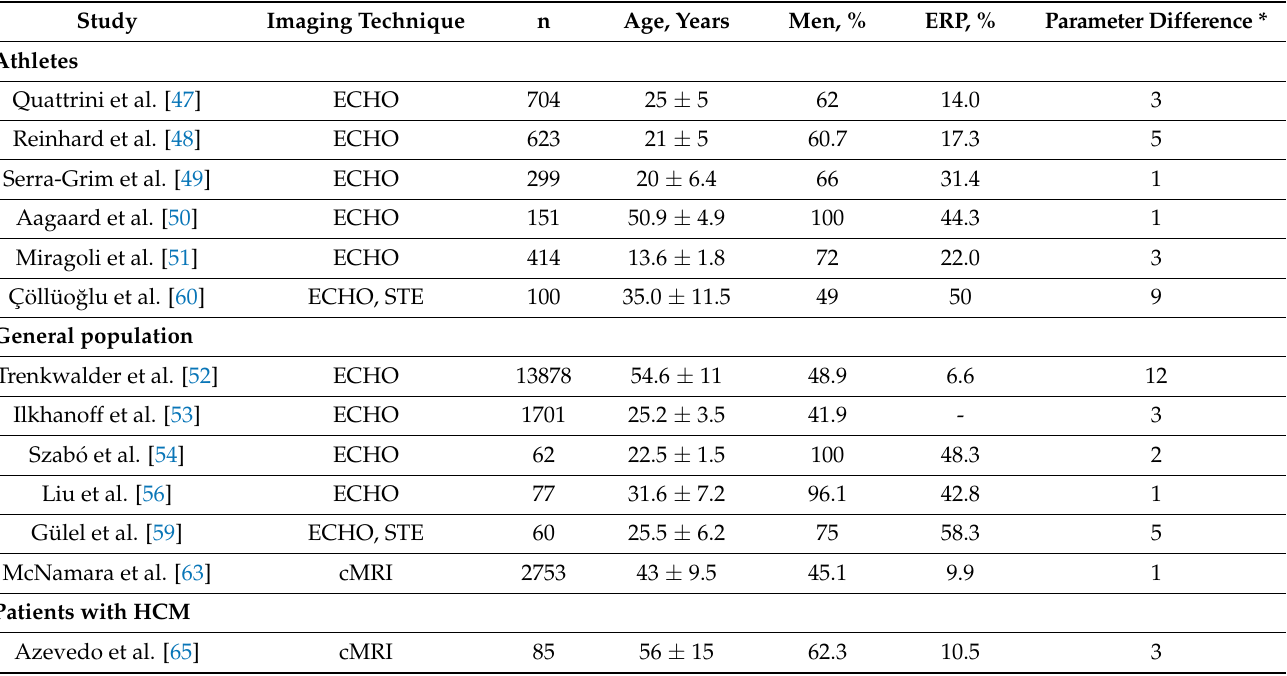
Table 3. Characteristics of studies investigating cardiac morphological and functional parameters in individuals with ERP, from different patient